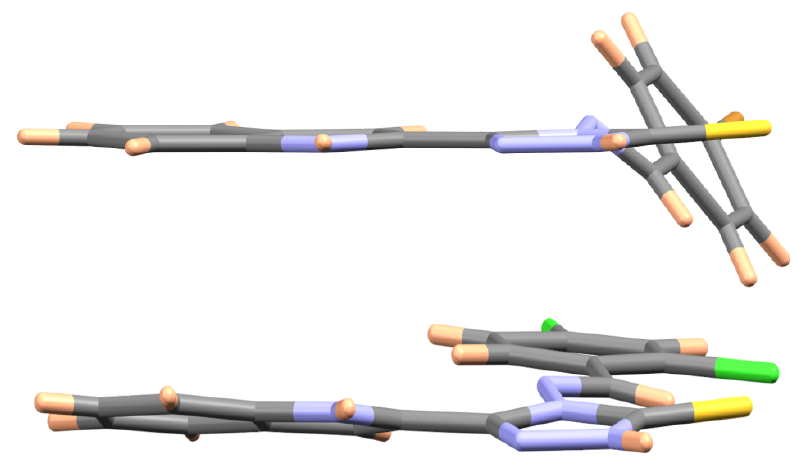
Figure 3. The capped stick model showing the different twists among the three connected ring